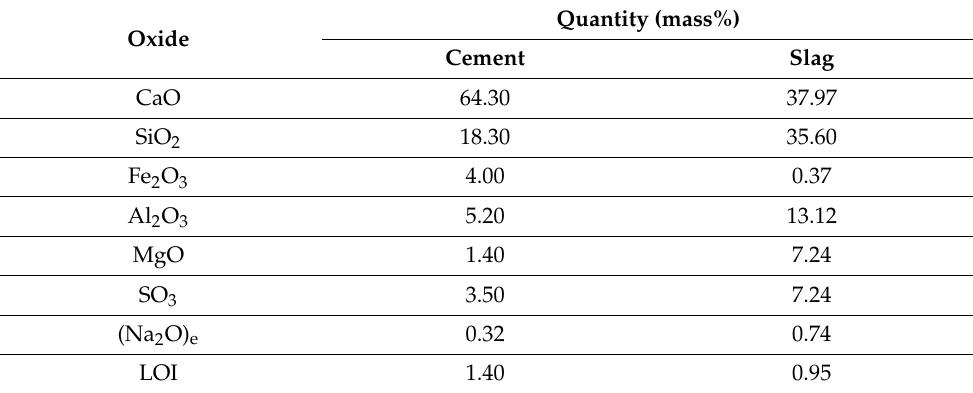
Table 1. Chemical composition of the cement and slag used in the